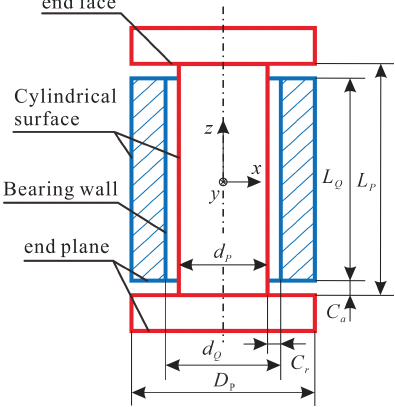
Figure 1. Spatial R -joint with radial and axial clearances. 2 Kinematic modeling of the R -joint